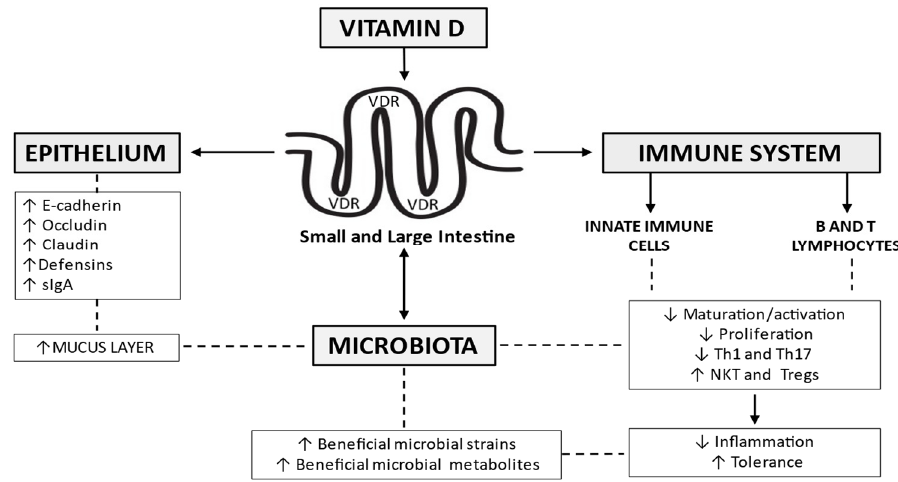
Figure 2. Vitamin D signaling affects the expression of several genes, regulates the immune system, and modulates the inflammatory response. It helps maintain epithelial integrity, through the regulation of tight junctions and adherens junctions’ components, as well as the release of antimicrobial peptides like the defensins. A role in the integrity of the mucus layer, as well as the composition of the gut microbiome, has been advocated. Th = T helper cells; NKT = natural killer T cells ; Tregs = regulatory T cells; sIgA = secretory immunoglobulin A; VDR = vitamin D receptor.